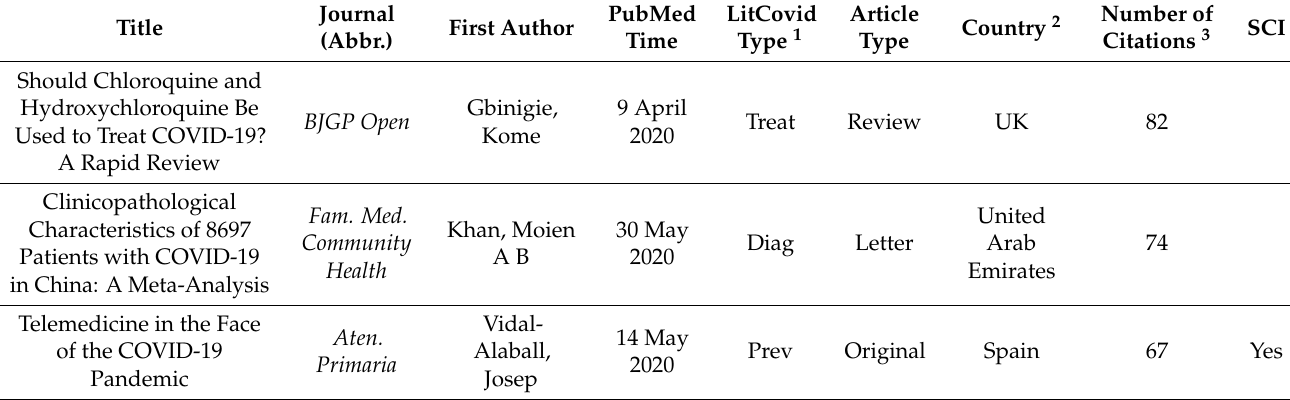
Table 4. Top influential COVID-19-related articles in family medicine journals indexed in PubMed in